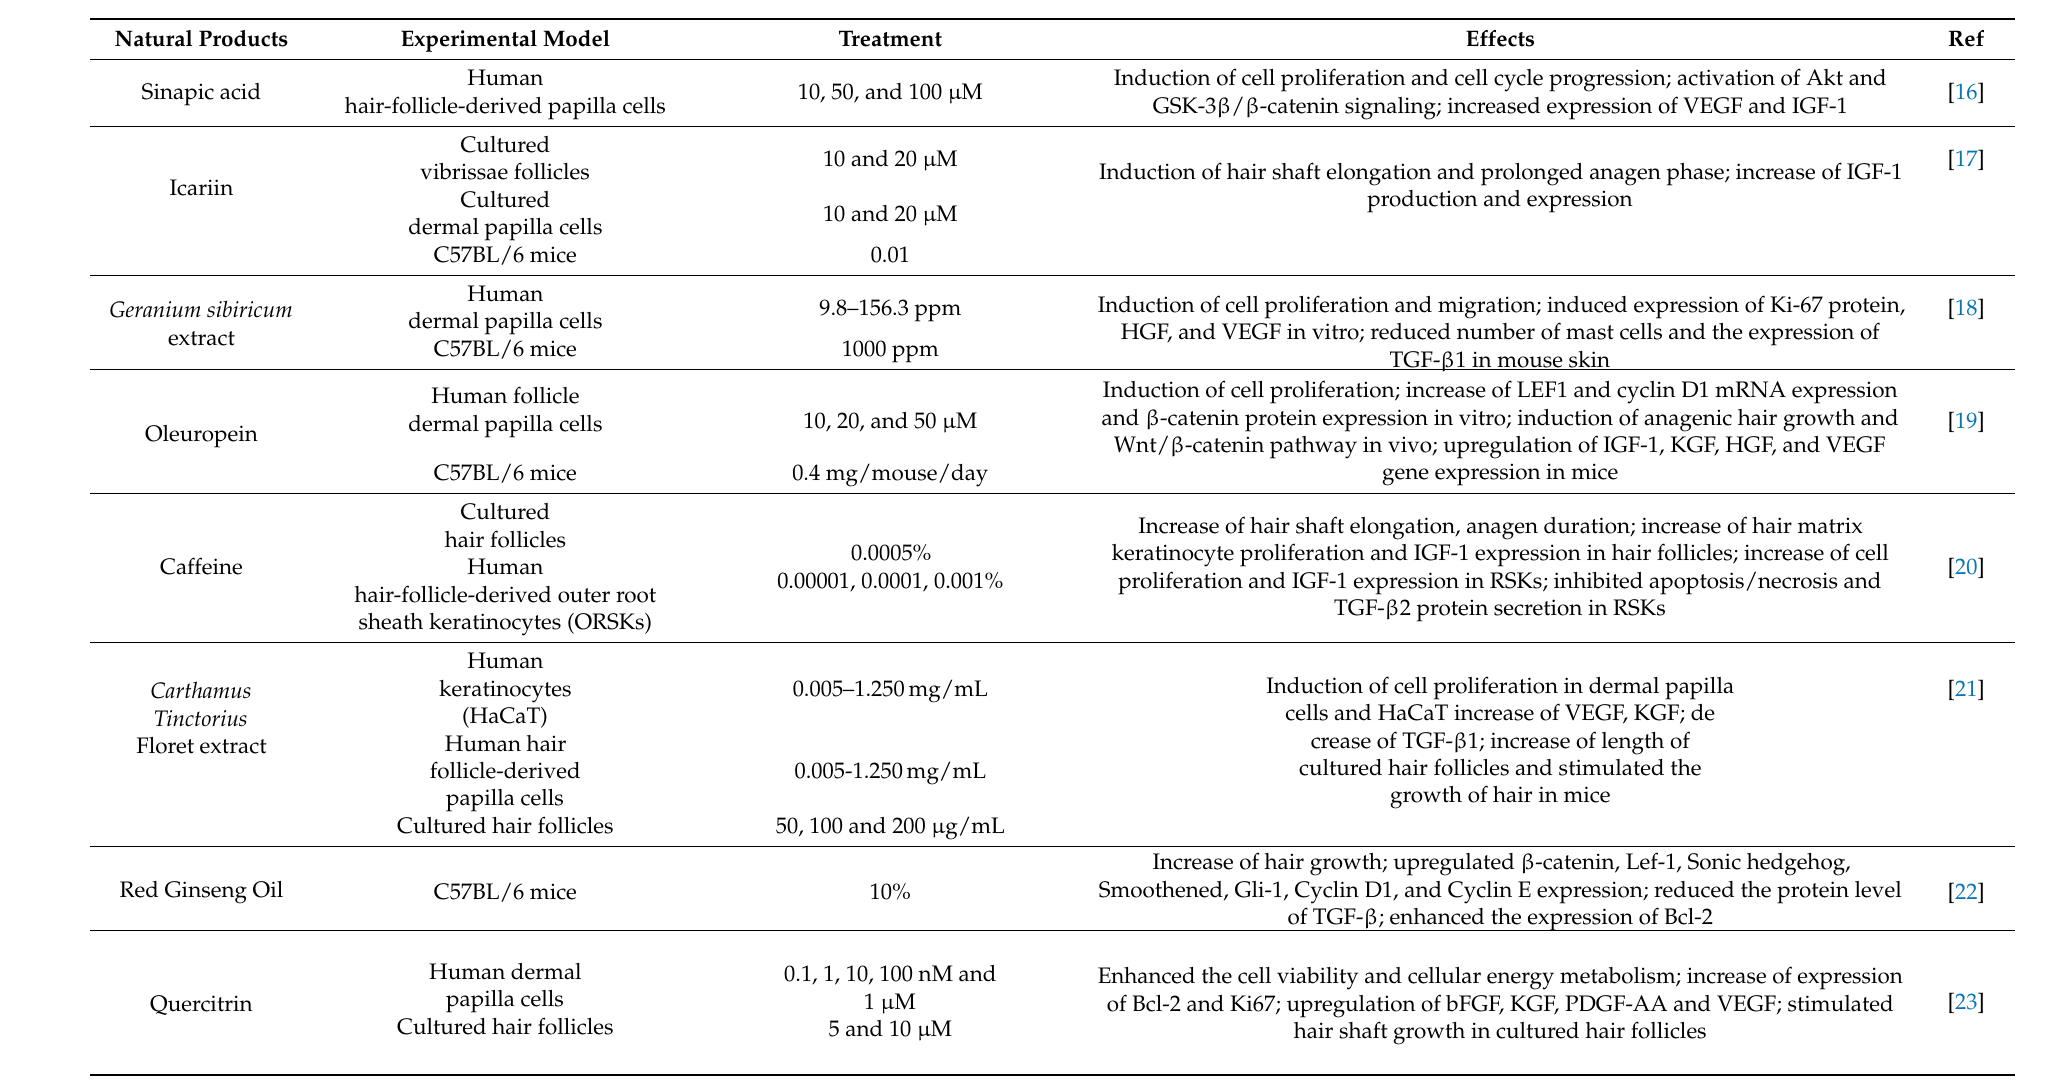
Table 2. Studies of hair-growth-promoting effects using natural products or their